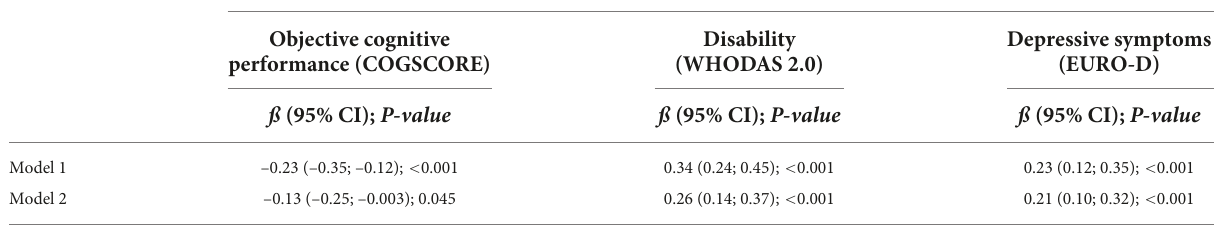
Model 1, linear regression models showing the associations of SCD (outcome) with objective cognitive performance, disability, and depressive symptoms (predictors). Model 2, linear regression models showing the associations of SCD (outcome) with objective cognitive performance, disability, and depressive symptoms (predictors) and adjusting for age, sex, and educationallevel. TABLE 4 Associations of subjective memory decline with objective memory performance, disability, and depressive symptoms.